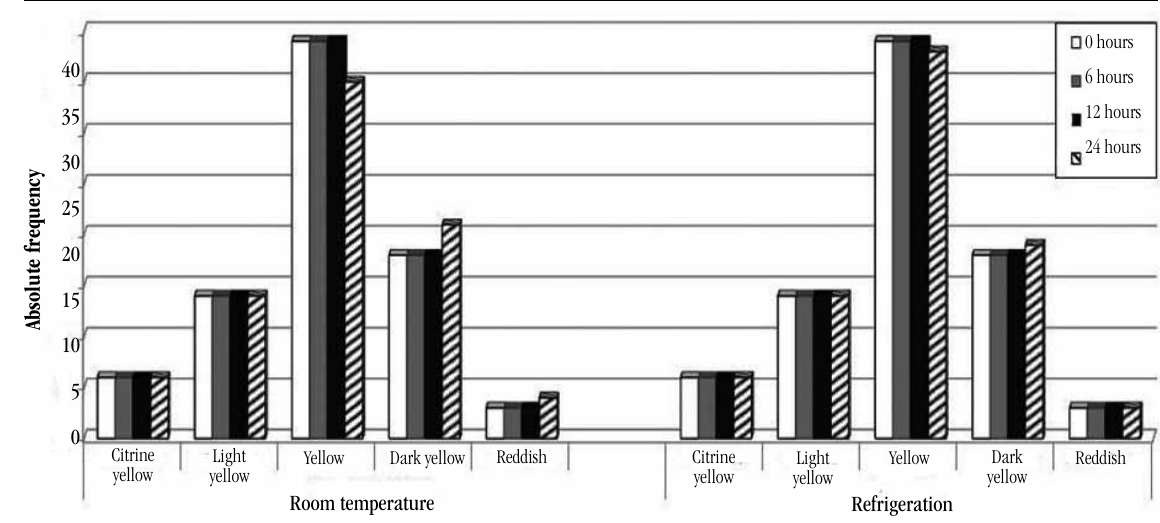
figurE 1 – Color of urine samples kept at room temperature and refrigerated storage at 2 to 8ºC for up to 24 hours ( n =